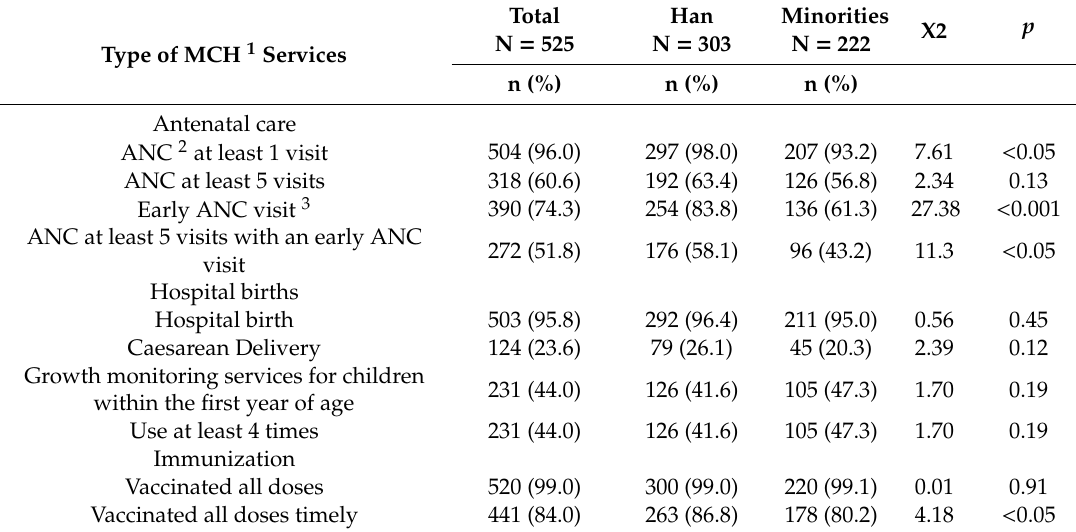
Table 2. Comparison on utilization of maternal and child health care between Han and ethnic minority